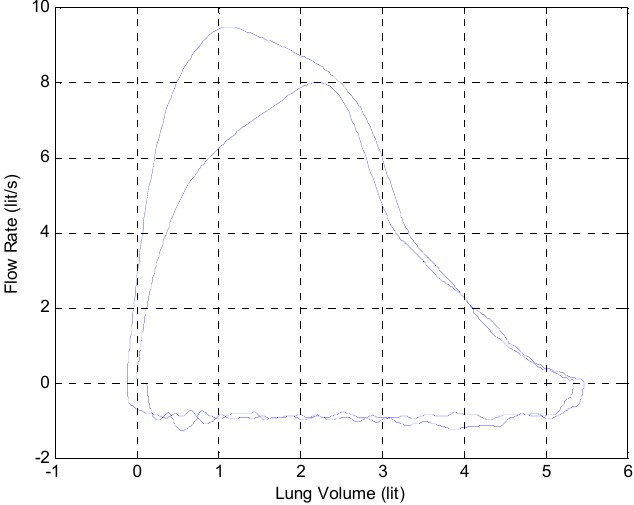
Figure 15. Plot of flow rate vs. volume for two breaths during an FEV test.